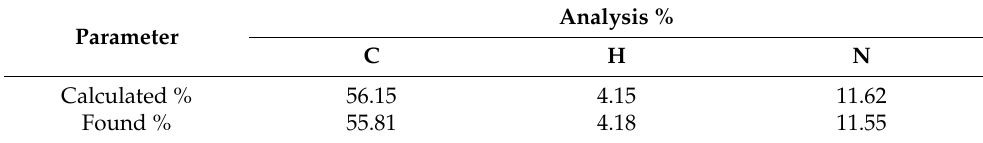
Table 1. Elemental analysis of alendronate (ALN) o-phenanthroline–Iron (II) complex. Parameter